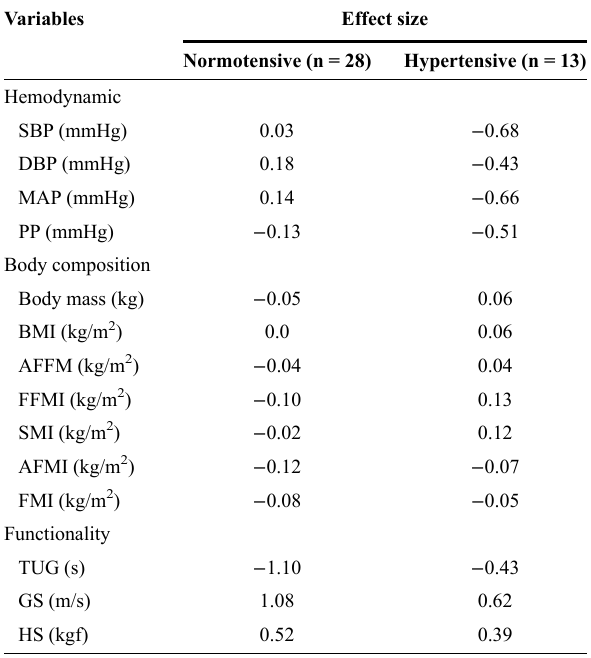
Table 3 - Effect size (d value) of observed outcomes (within-group) after 12 weeks of progressive resistance training (n = 41).